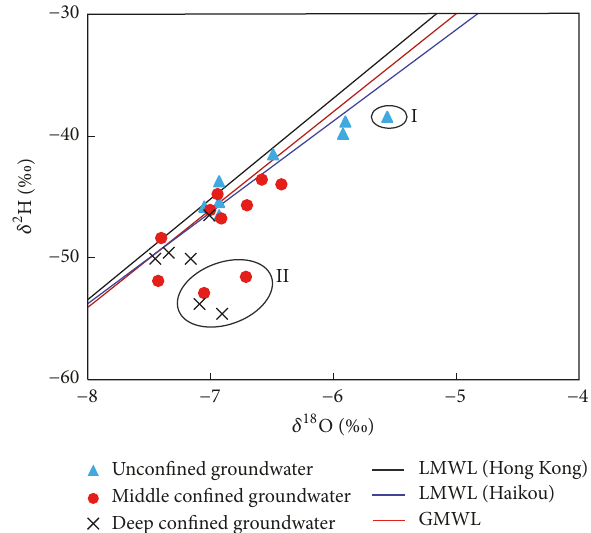
Figure 5: Stable isotope compositions of groundwater in the multilayered aquifers of Zhanjiang.